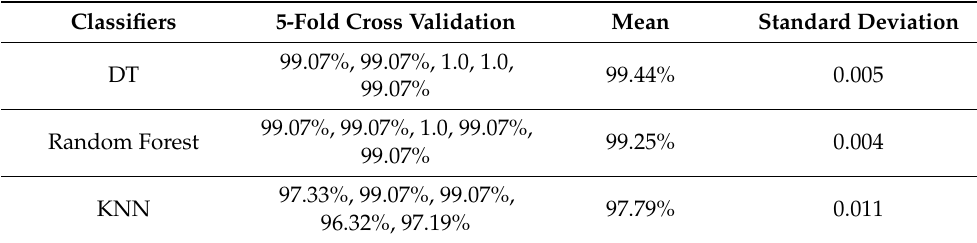
Table 6. The performance of DT classifier.